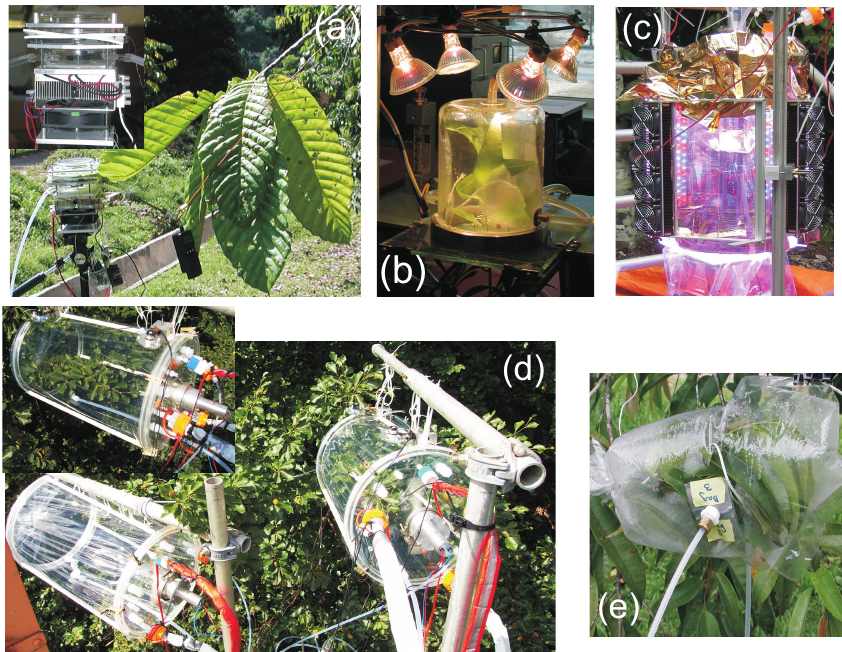
Fig. 1. Comparison of various enclosure systems currently used for measurement of BVOC emissions from plants: (a) two-halved glass cuvette with a polymer gasket and thermoelectric (Peltier) temperature control for field measurements (Peter C. Harley, NCAR, Boulder, USA), (b) double-layered glass cuvette with thermostatted water between the two glass layers for laboratory measurements (for detailed description see Copolovici and Niinemets, 2010; Rasulov et al., 2009a), (c) Teflon® (FEP) film branch enclosure for field measurements with artificial illumination by blue and red LEDs (J¨urgen Kesselmeier, Max Planck Institute for Chemistry, Mainz, Germany), (d) Teflon® (FEP) film branch enclosure system for measurements under natural illumination and under ambient temperatures; the system consists of two enclosures of 75l (air flow rate 40lmin − 1 ) , one for reference air sampling and the other for plant sampling, and each enclosure is equipped with 2 light sensors and 4 thermocouples, two attached on the leaves at the lower part of the branch and two at the upper part (for details Dindorf et al., 2006; Kuhn et al., 2002b), and (e) polyvinylfluoride (PVF, Tedlar® ) bag for field measurements (Chris D. Geron, US EPA). The enclosures are installed on tropical evergreen dipterocarps Dipterocarpus applanatus (a) and Dryobalanops aromatica ( e , both experiments conducted in Danum Valley Field Centre, Sabah, Borneo, Malaysia (117 ◦ 49 0 E and 5 ◦ 01 0 N) in June 2008), on temperate deciduous shrub Salix viminalis (b) in the lab, on temperate deciduous tree Fagus sylvatica ( d , experiments conducted in deciduous broad- leaved forest close to J¨ulich, Germany, 50 ◦ 54 0 N, 6 ◦ 25 0 E), while an empty cuvette is shown in (c)